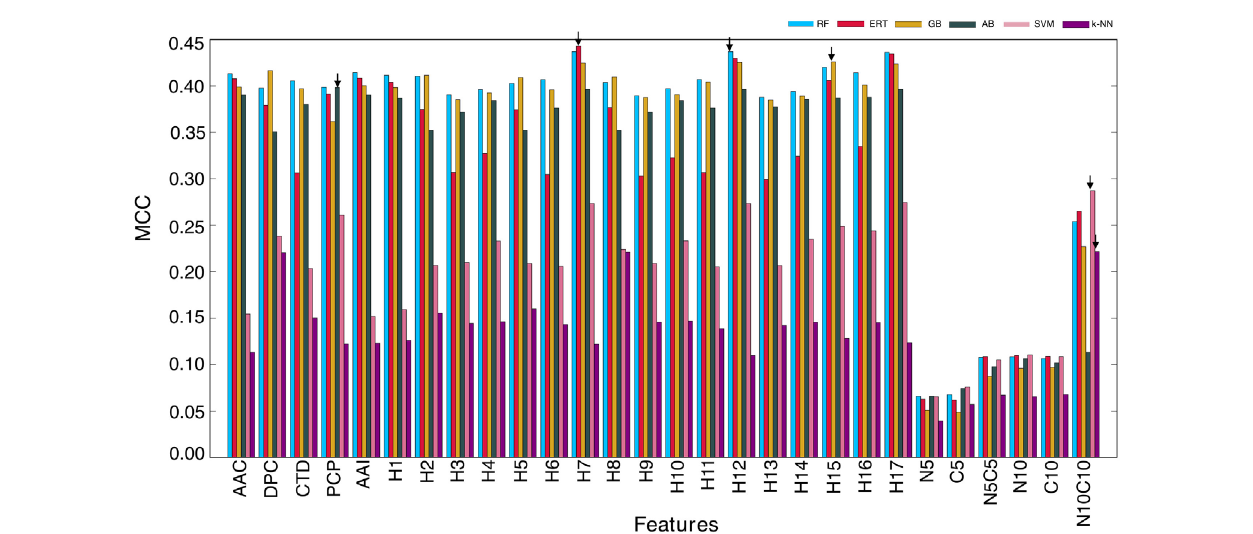
FIGURe 3 | Performance of six different ML-based classifiers. Performance of various classifiers in distinguishing between B-cell epitopes (BCEs) and non-BCEs. A total of 27 classifiers were evaluated using 10 independent 5-fold cross-validation techniques, and their average performances in terms of AUC is shown. The final selected model for each ML-based method is shown with arrows. Abbreviations: AAC, amino acid composition; DPC, dipeptide composition; CTD, chain-transition- distribution; AAI, amino acid index; PCP, physicochemical properties; H1: AAC + AAI; H2: AAC + DPC + AAI; H3: AAC + DPC + AAI + CTD; H4: AAC + DPC + AAI + CTD + PCP; H5: AAC + DPC; H6: AAC + CTD; H7: AAC + PCP; H8: AAI + DPC; H9: AAI + DPC + CTD; H10: AAI + DPC + CTD + PCP; H11: AAI + CTD; H12: AAI + PCP; H13: DPC + CTD; H14: DPC + CTD + PCP; H15: DPC + PCP; H16: CTD + DPC; H17: AAC + AAI + PCP; N5: BPFN5; C5: BPFC5; N5C5: BPFN5 + BPFC5; N10: BPFN10; C10: BPFC10; and N10C10: BPFN10 +